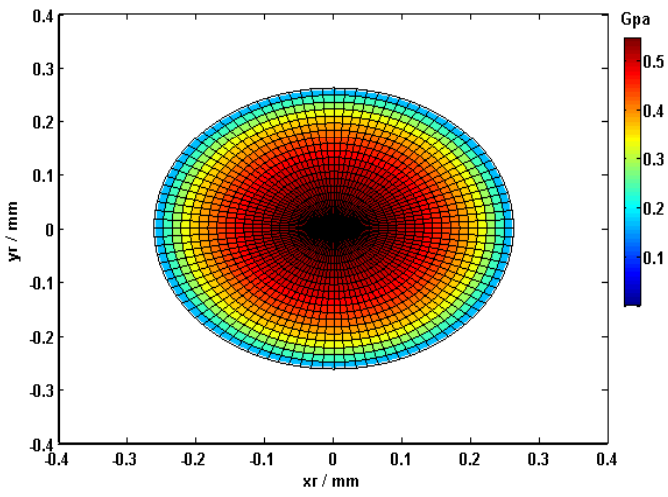
Figure 9. Normal stress distribution on the circular thin plate.